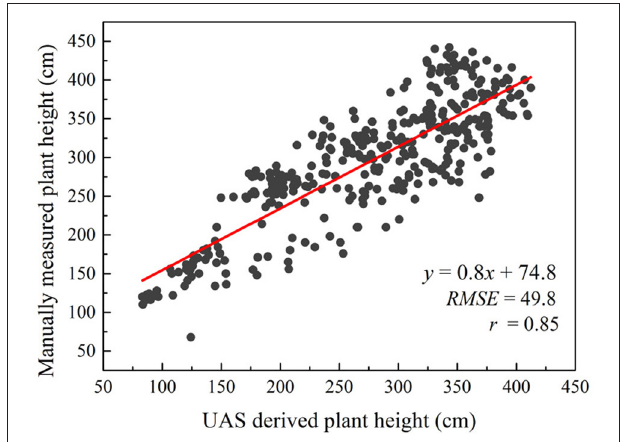
FIGURE 4 | Correlation between UAS estimated plant height and manually measured plant height over 363 plots on September 11,